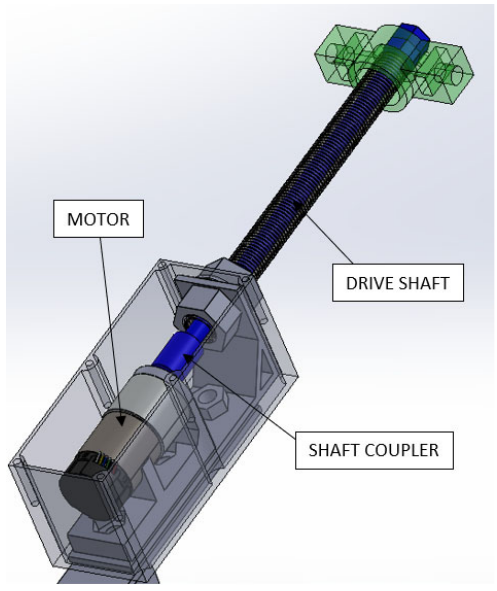
Figure 9. Transmission parts.